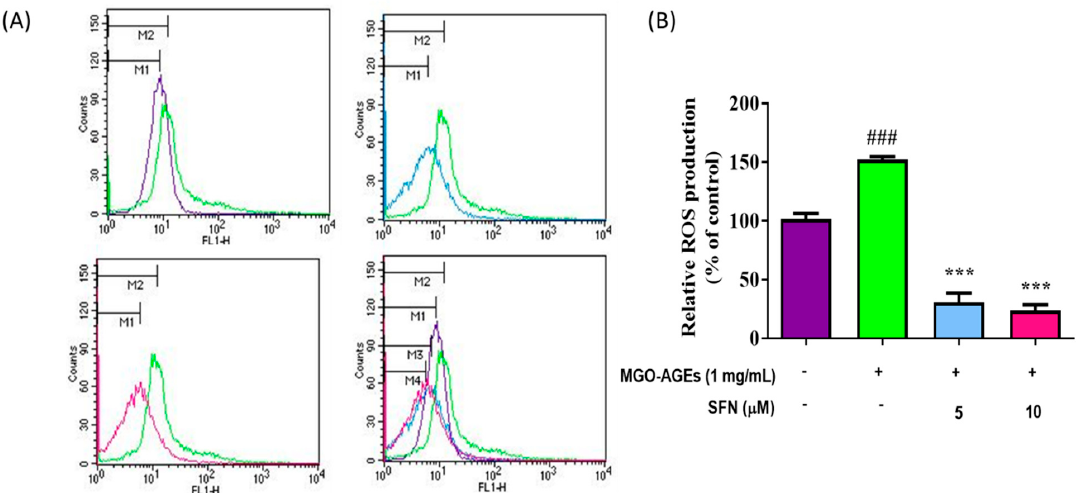
Figure 2. SFN pretreatment reduced MGO-AGEs-induced reactive oxygen species (ROS) production in microglial cells. BV2 cells were pretreated with SFN following MGO-AGEs (1 mg / mL) treatment. ROS production in the MGO-AGEs group and MGO-AGEs + SFN co-treatment groups was evaluated using flow cytometry and compared with that in the control group ( A,B ). *** p < 0.001 indicates significant differences compared with AGEs alone, whereas ### p < 0.001 indicates significant differences compared with an untreated control group.